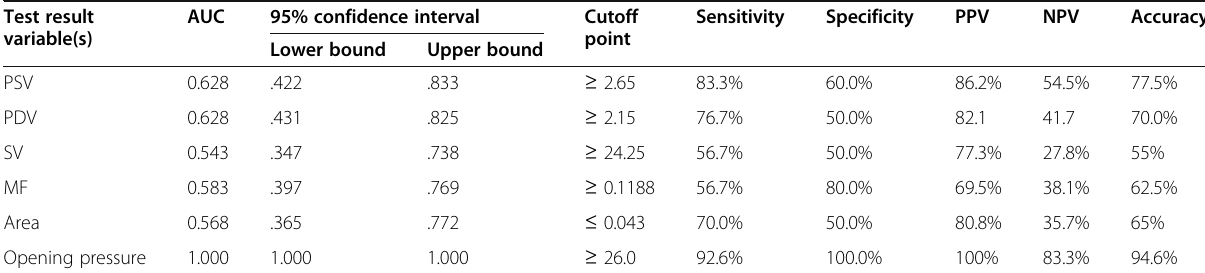
Table 3 Validity of CSF flowmetry and opening pressure in differentiating cases and